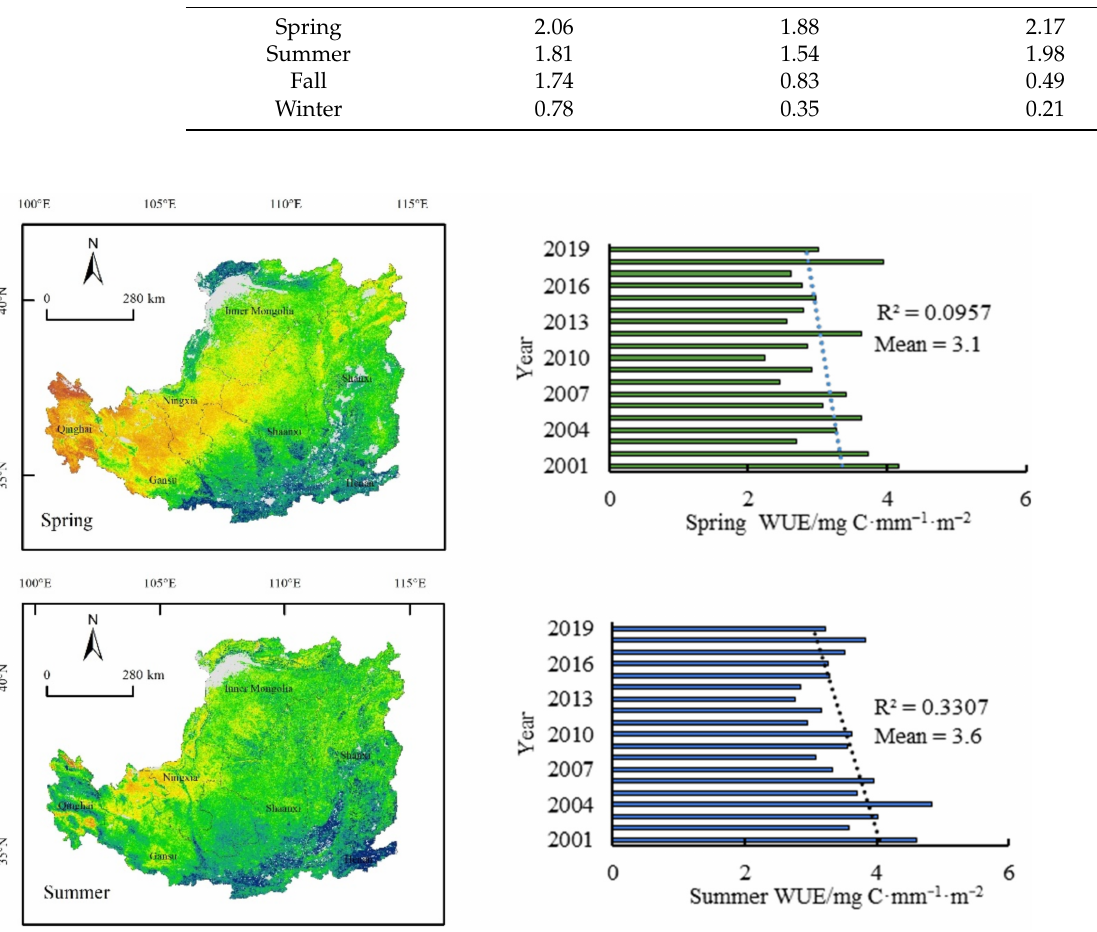
Table 3. Seasonal WUE of different vegetation types (mg C · mm − 1 · m − 2 ). Forests Shrublands Grasslands Spring